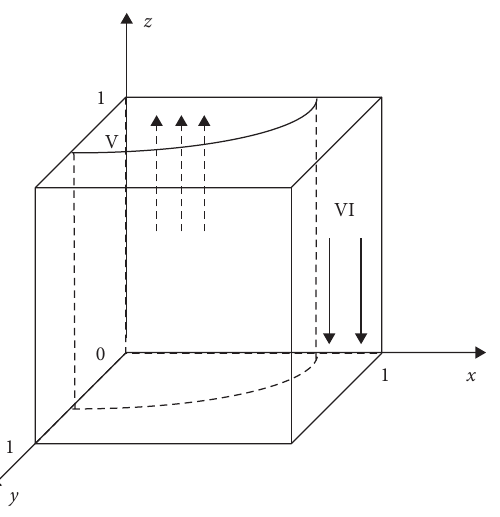
Figure 3: The public’s dynamic